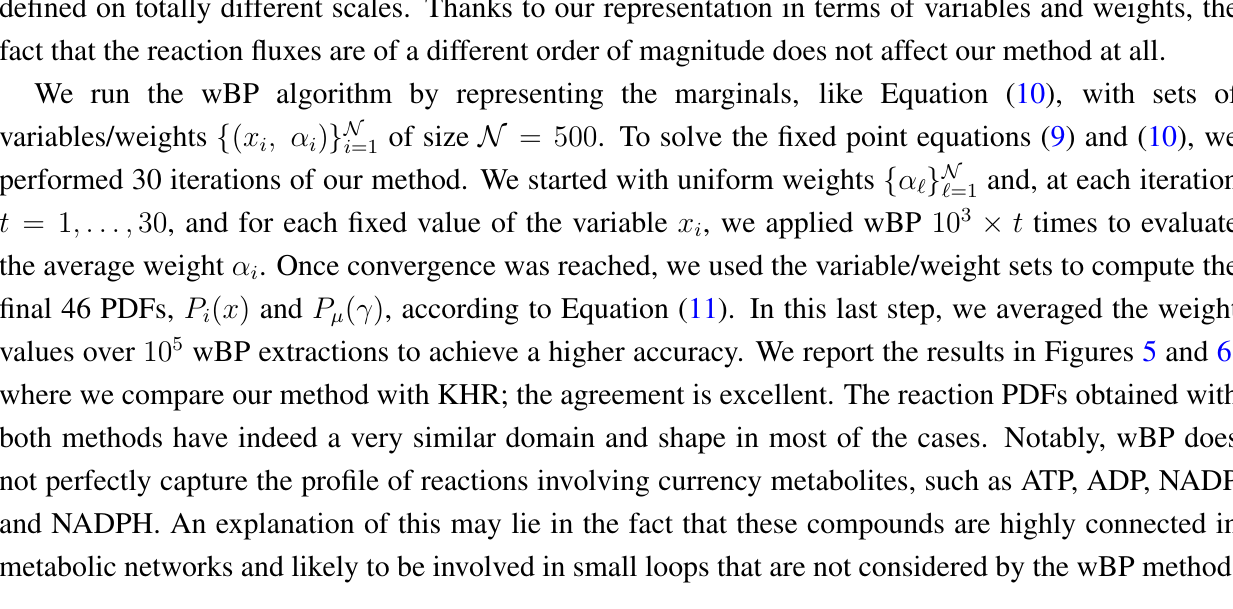
Figure 5. Results for human red blood cell. Here, we draw a pictorial representation of the system as a directed bipartite graph. Reaction nodes are plotted with their PDFs and metabolite nodes with green squares. Arrows entering (resp. leaving) a reaction stand for a ( x ) , for the internal reactions substrate (resp. a product). We have plotted the marginals, P i ( γ ) for the exchange rates (these are the leaves on the bipartite graph). together with the P µ For the densities, we have used the wBP method (red filled plots) and have compared them with the KHR algorithm (blue solid